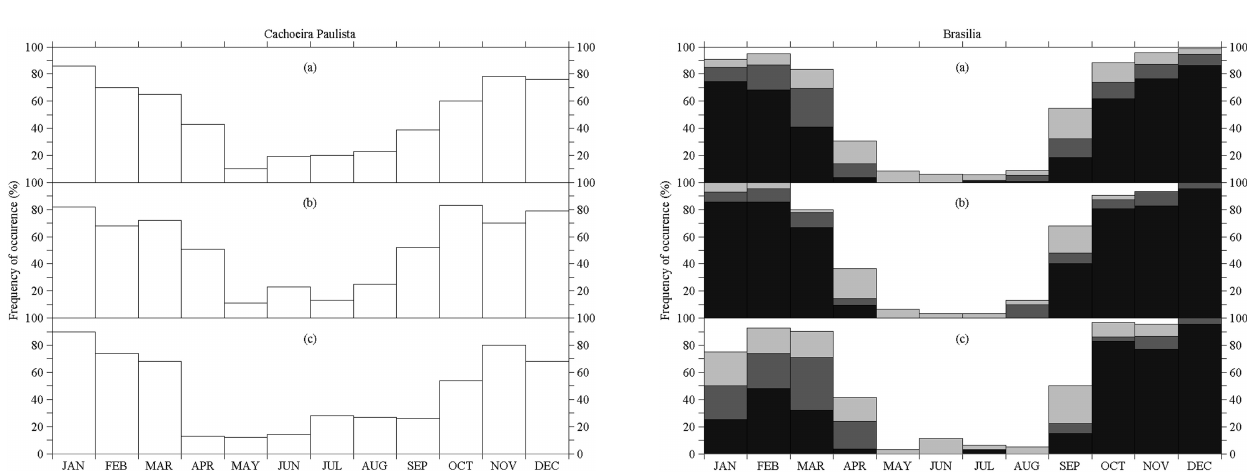
Fig. 4. Frequency of occurrence of the ionospheric irregularities over Brasilia (gray, dark, and black denote the frequency propor- tions of Fp > 50, 100, and 200, respectively): (a) half solar cycle (1995–2000), (b) high solar activity (solar maximum, 2000), and (c) low solar activity (solar minimum,